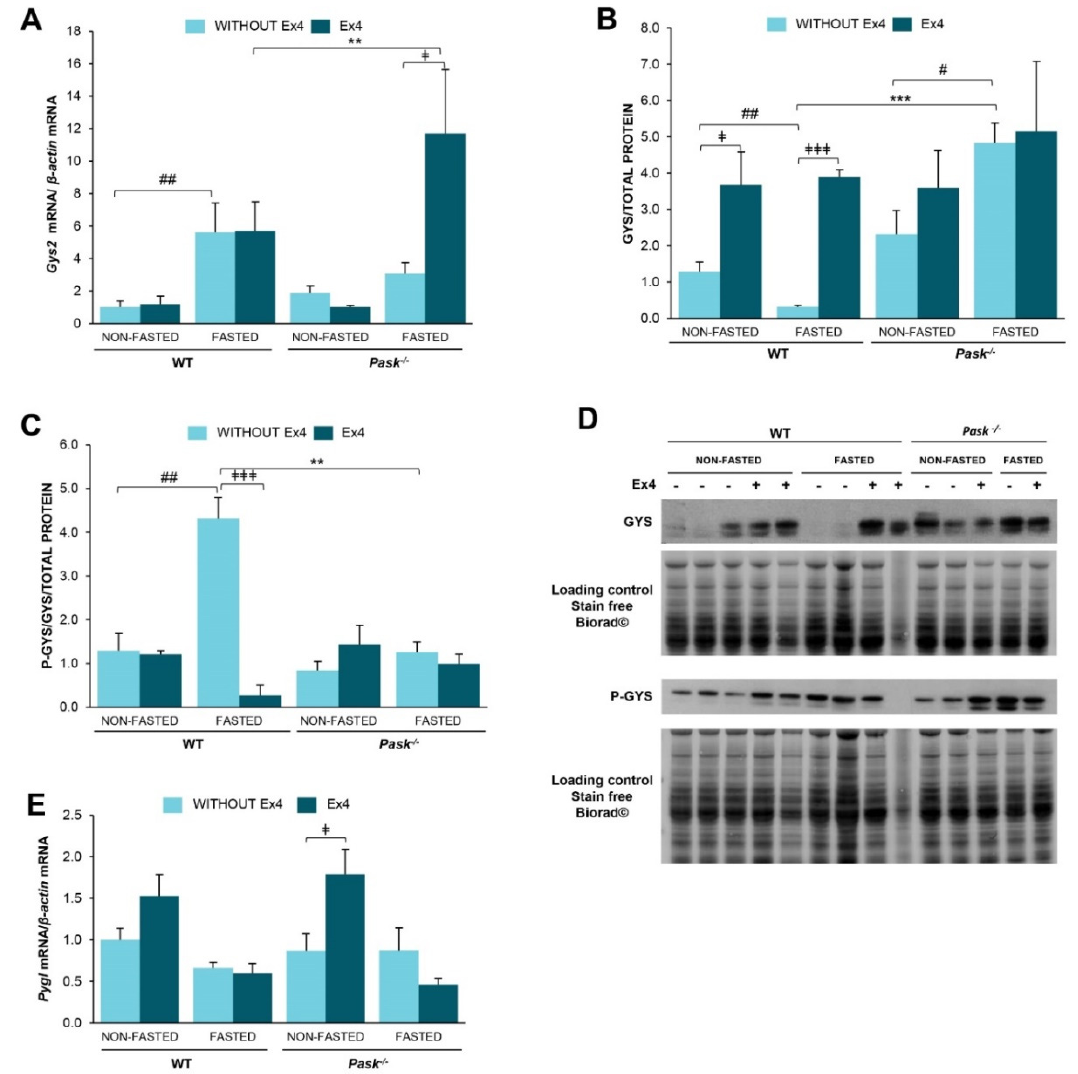
Figure 5. Exendin-4 and PASK deficiency alter Gys2 and Pygl gene expression as well as GYS protein expression and P-GYS. Quantitative real-time PCR was used to analyze the expression of glycogen synthase Gys2 ( A ) and glycogen phosphorylase Pygl ( E ). mRNA levels were measured in non-fasted (NON-FASTED) and 48-h fasted (FASTED) livers from wild-type mice (WT) and PASK-deficient mice ( Pask − / − ) treated or not with exendin-4 (Ex4). The mRNA levels were normalized by mRNA of β -actin used as housekeeping gene. Data are shown as mean ± SEM of 3–5 animals per group and expressed as fold-over the non-fasted wild-type mice of 3–5 animals per condition (** p < 0.01 WT vs. Pask − / − , ## p < 0.01 non-fasted vs. 48-h fasted, ǂ p < 0.05 vehicle vs. exendin-4 by two-way ANOVA followed by Tukey post-hoc test). Immunoblot analysis of total Glycogen synthase (GYS) ( B , D ) and the level of phospho-GYS (P-GYS) protein expression ( C , D ) in the liver from wild-type (WT) and PASK-deficient mice ( Pask − / − ). Liver lysates from non-fasted (NON-FASTED) and 48-h fasted (FASTED) specimens in the presence or absence of exendin-4 (Ex4) were processed for Western blot analysis. A representative blot of 2 prepared blots is also shown ( D ), from which the data shown in the graph were collected ( B,C ). The values were normalized by total protein detected by Stain-Free Biorad© and expressed as fold-over the non-fasted wild-type mice. Data are shown as mean ± SEM of 3–5 animals per condition and expressed by fold-over the non-fasted wild-type mice. ** p < 0.01, *** p < 0.001 WT vs. Pask − / − , # p <0.05, ## p <0.01 non-fasted vs. 48-h fasted and ǂ p < 0.05, ǂǂǂ p < 0.001 vehicle vs. exendin-4 by two-way ANOVA followed by Tukey post-hoc test.